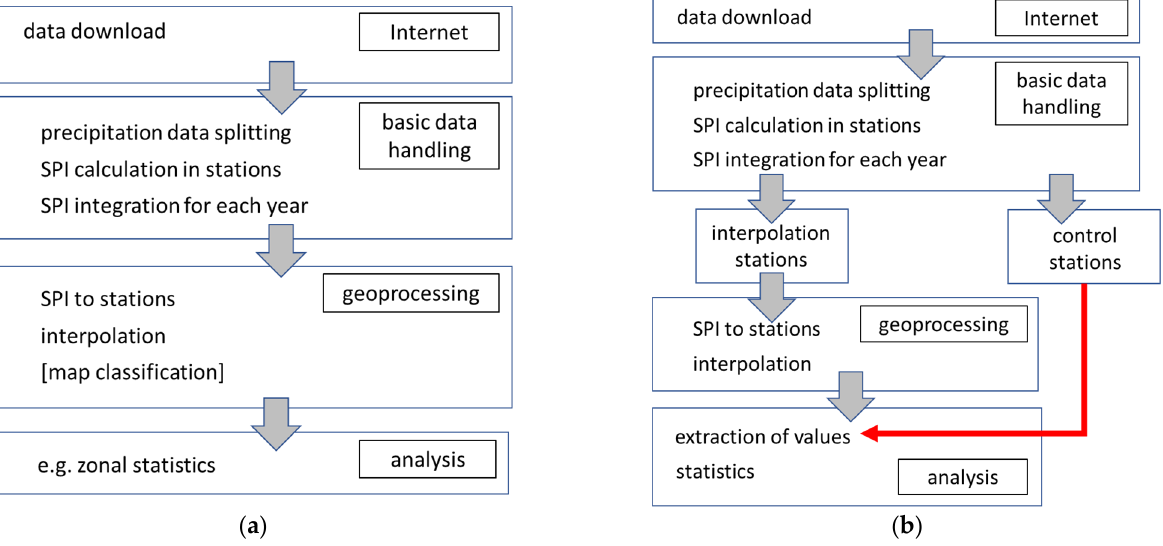
Figure 3. Developed algorithms for interpolation: ( a ) basic form (without control stations), ( b ) ad- vanced form for accuracy assessment (with control stations). ( b ) advanced form for accuracy assessment (with control